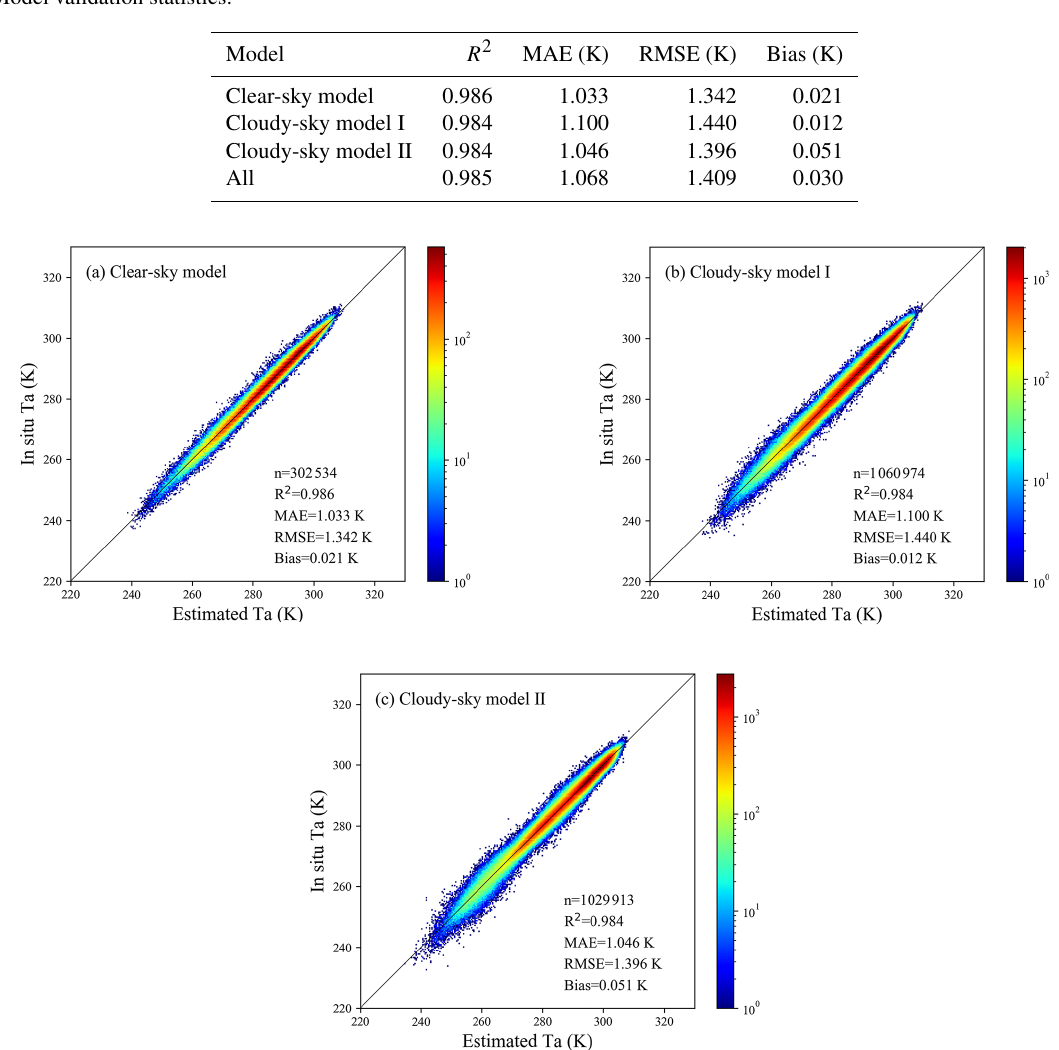
Table 2. Model validation statistics.